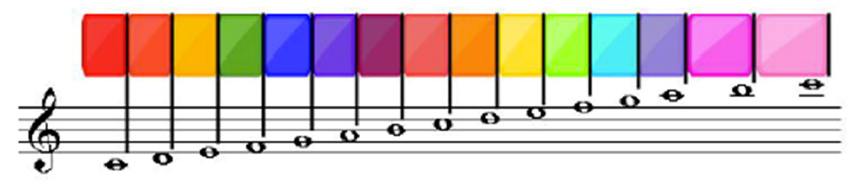
Figure 7. Colors associated with musical notes.